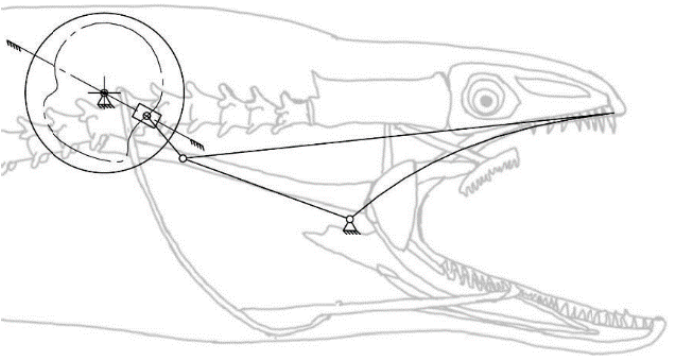
Figure 6. Kinematic chain representation of the oral jaw: inverted slider – crank mechanism. As a result, the structures of both jaw mechanisms are chosen as an offset slider – crank mechanism combined with an anti-parallel four-bar mechanism for the pharyngeal jaw, and an inverted slider – crank mechanism with the input of a prismatic joint that is driven with a cam profile (Figure 7).